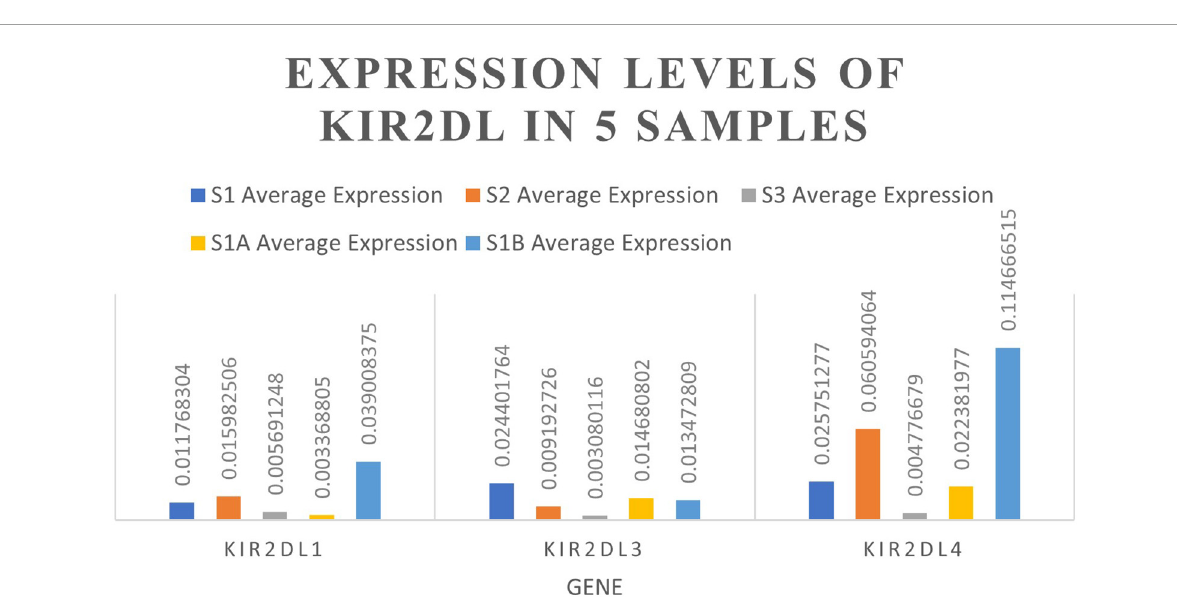
FIGURE4 Differences in the expression levels of KIR2DL1, KIR2DL3, and KIR2DL4 among five